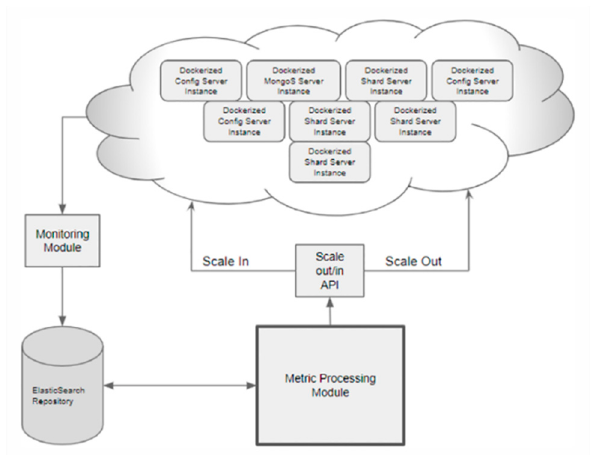
Figure 10. Data repository scaling real-time API architecture.